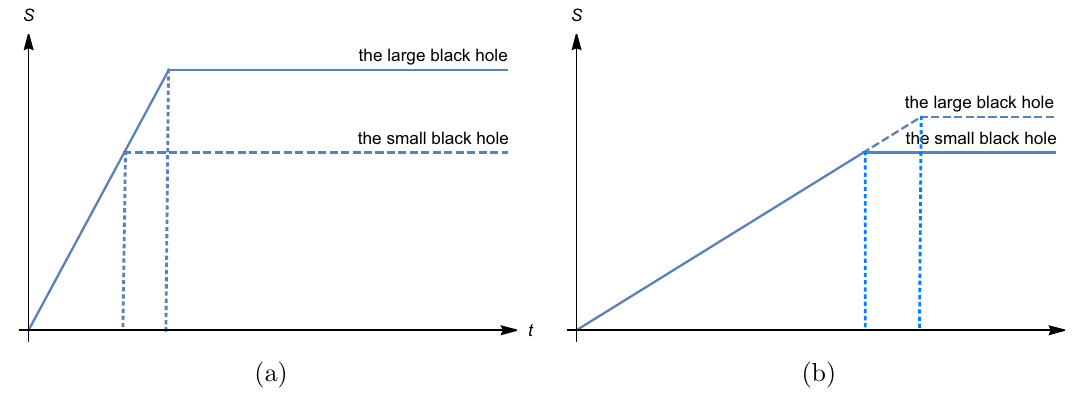
Fig. 9 Page curves for different temperatures. a Page curve at the temperature which is higher than the critical temperature. b Page curve at the temperature which is lower than the critical temperature